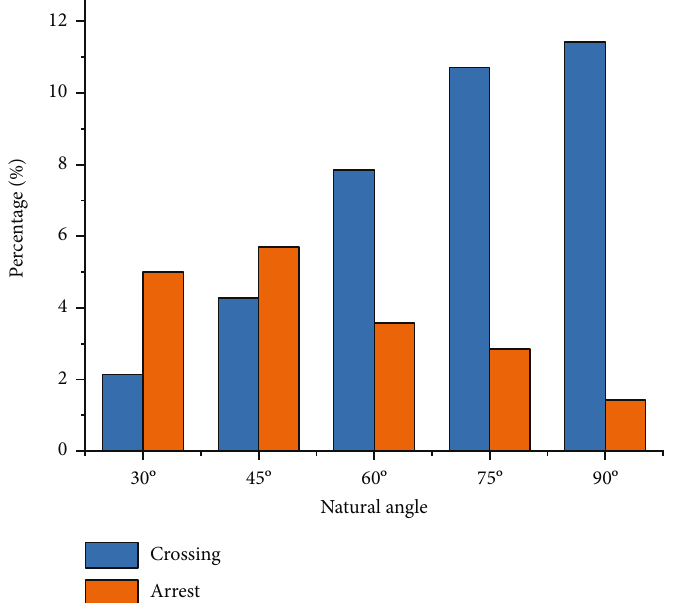
Figure 9: Numbers of events that hydraulic fractures are crossing and arrested by natural fractures with natural fracture orientations.